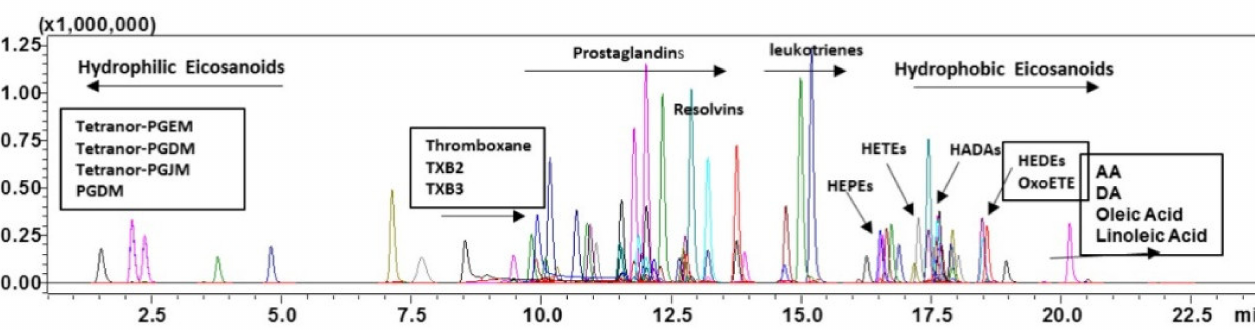
Figure 1. Representative overlaying chromatograms of all eicosanoid standards at 50 ng/mL under final chromatogra- phy and detection conditions. Thromboxane (TXB), hydroxy eicosapentaenoic acid (HEPEs), hydroxyeicosatetraenoic acid (HETEs), hydroxy docosahexaenoic Acid (HADAs), hydroxy eicosadienoic acid (HEDEs), oxo-eicosatetraenoic acid (OxoETE), Arachidonic acid (AA) and docosahexaenoic Acid (DA).